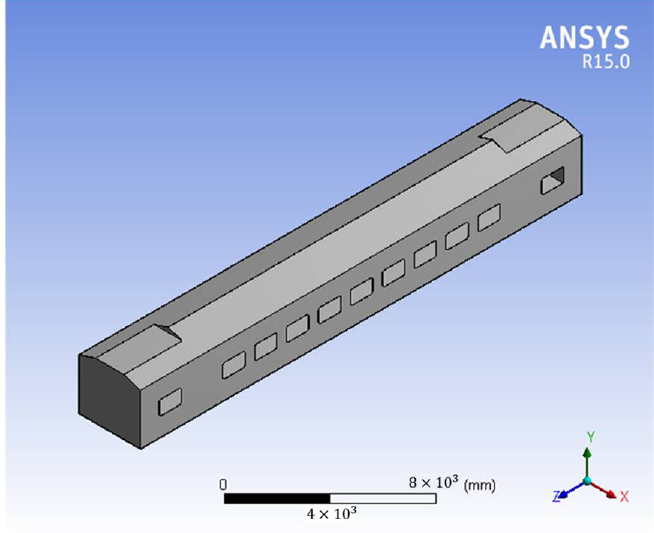
Figure 3. Model of the passenger railway LHB coach in ANSYS.